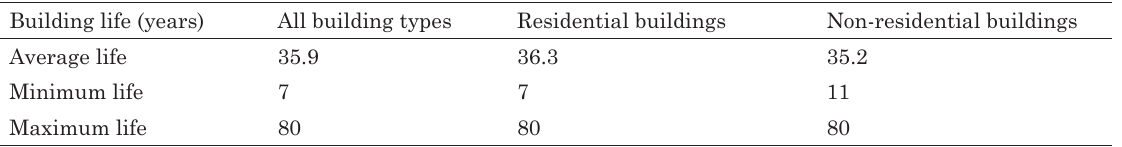
Table 2. Lifespan of demolished